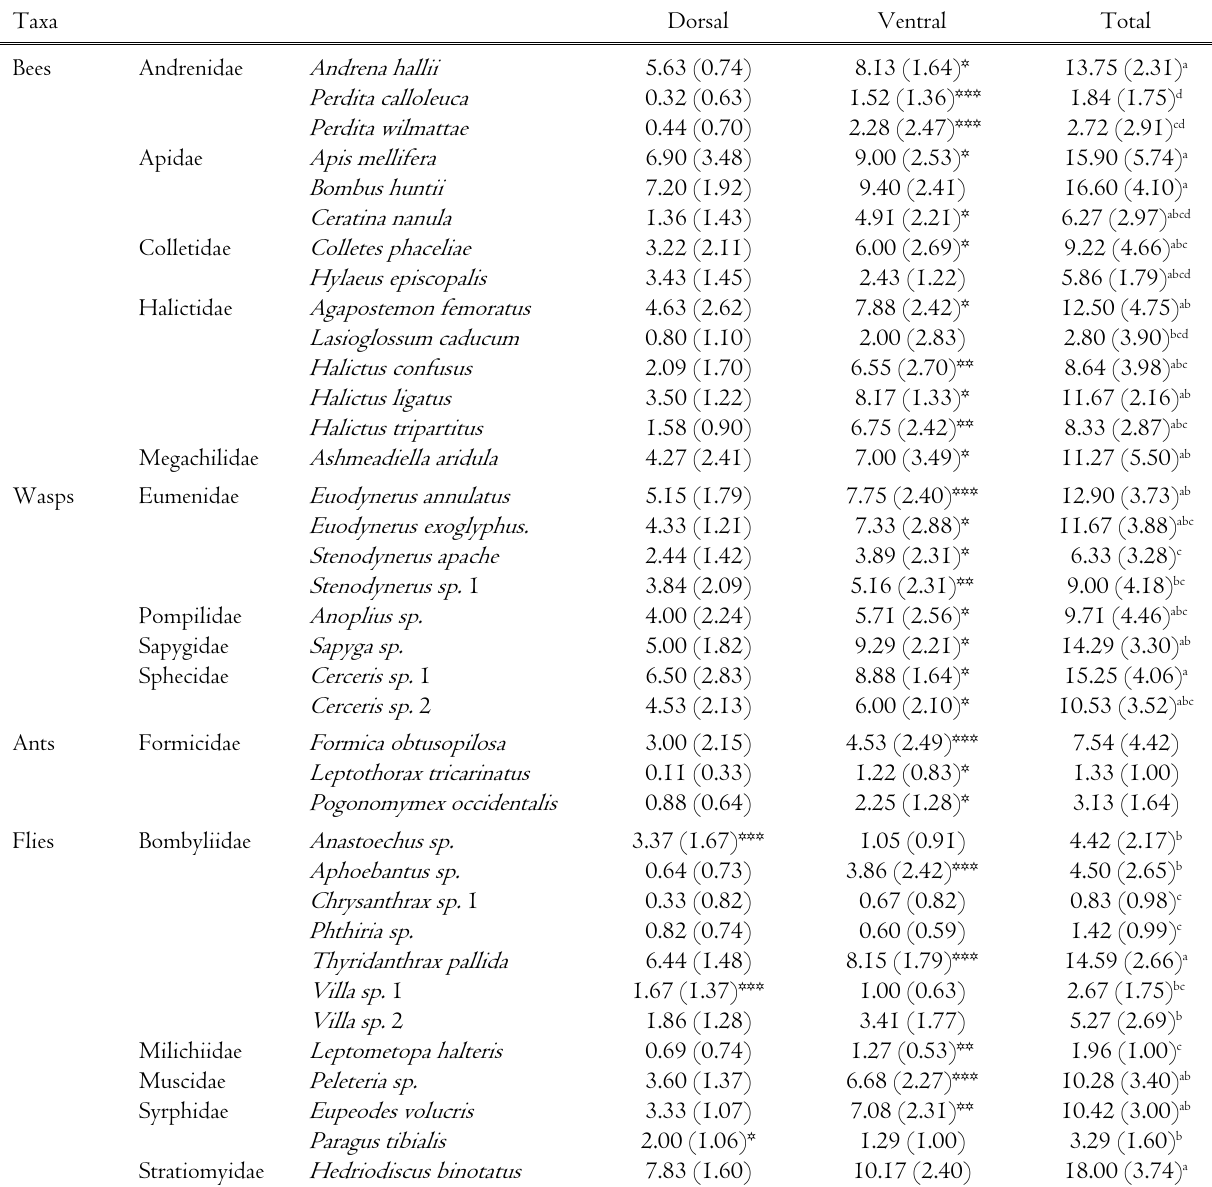
Table 2. Mean number of individuals and species (± sd) captured per person hour per week at the flowers of E. pelinophilum at disturbed (DI) and undisturbed (UN) sites. Number of weeks sampled = 7 in all cases. P = Probability; Wilcoxon Matched-Pairs Signed Rank Tests.